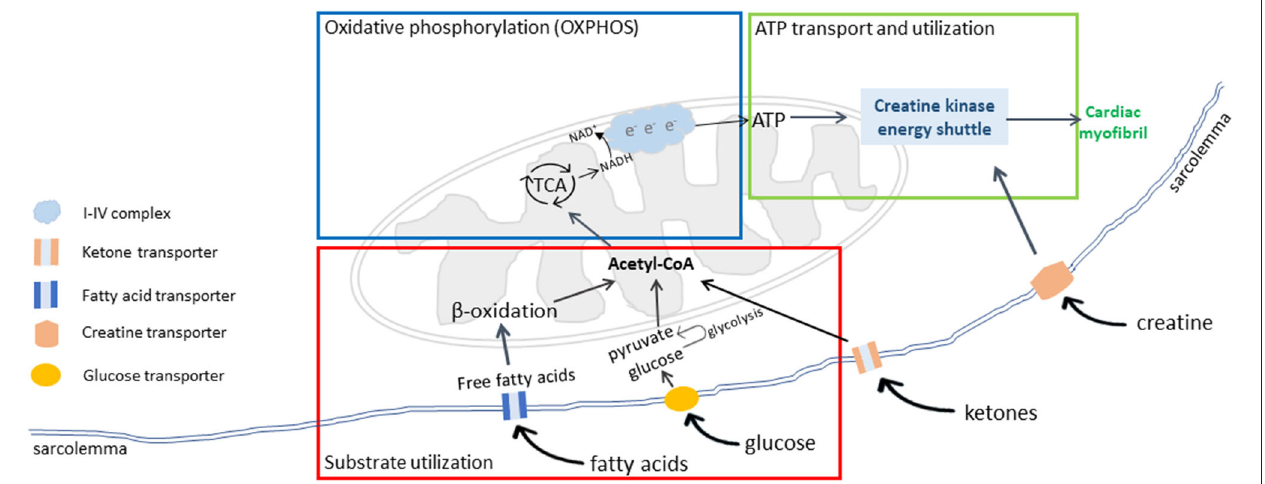
FIGURE 1 | Cardiac energy metabolism. There are three interconnected components of cardiac energy metabolism: substrate transport and utilization (red box), mitochondrial oxidative phosphorylation (OXPHOS) for energy production (blue box), and ATP transport and utilization by cardiac myofibrils (green box). Adapted from Neubauer ( 6).